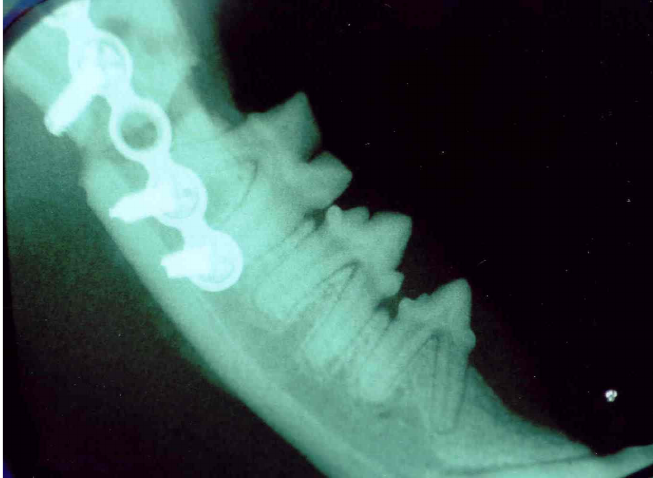
FIGURE 5 - Intraoral radiograph taken 1 week after surgery shows the radiolucent line corresponding to the osteotomy. Cat 5 of Group